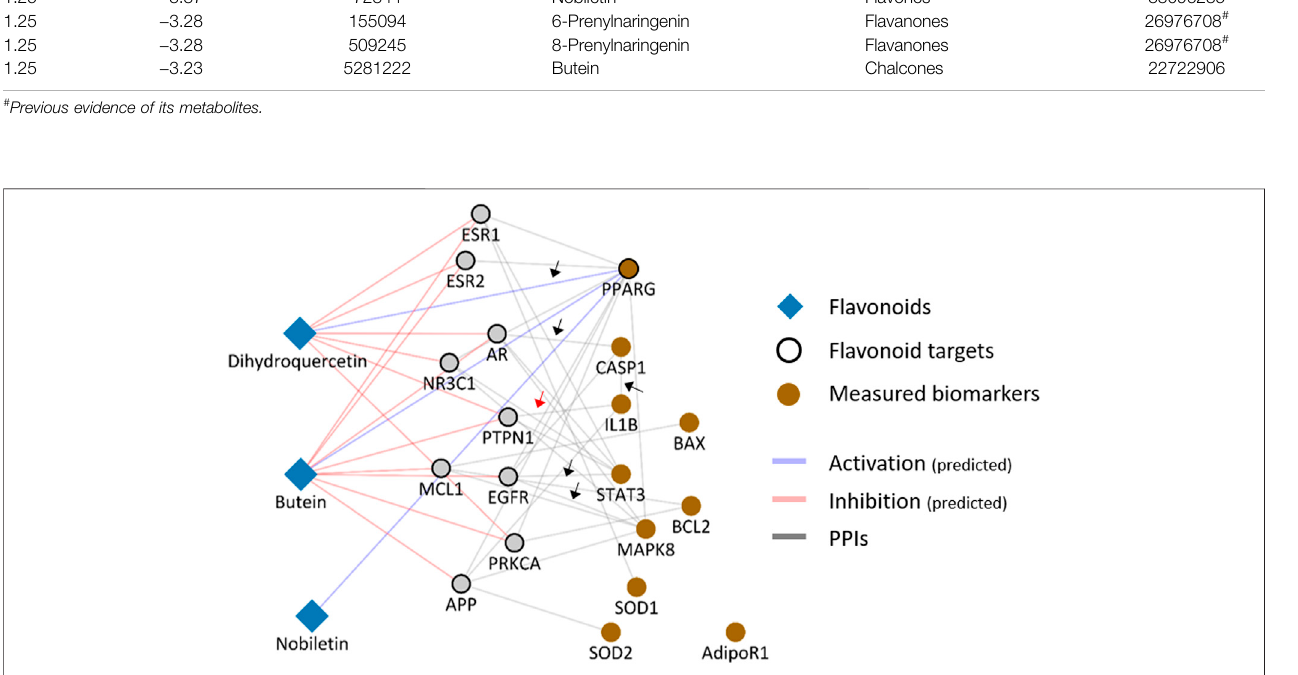
FIGURE 4 | A compound-protein network between selected fl avonoids and NAFLD-associated proteins. A network including the interaction between fl avonoid targets and NAFLD-associated proteins was constructed to elucidate the mechanisms of dihydroquercetin, butein, and nobiletin. Black and red arrows indicate interactions consistent or inconsistent with the inferred mechanism of fl avonoids against NAFLD,